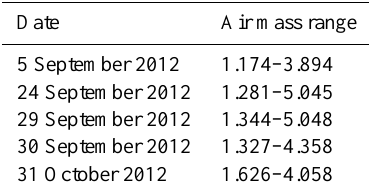
Table 1. Dates of the experiment and air mass